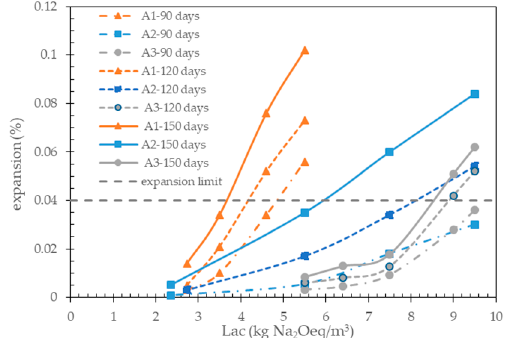
Figure 7. Determination of the TAL values for the aggregates tested with the accelerated CPT using di ff erent expansion limit criteria.